Question: Condense the content of this figure into a single sentence.
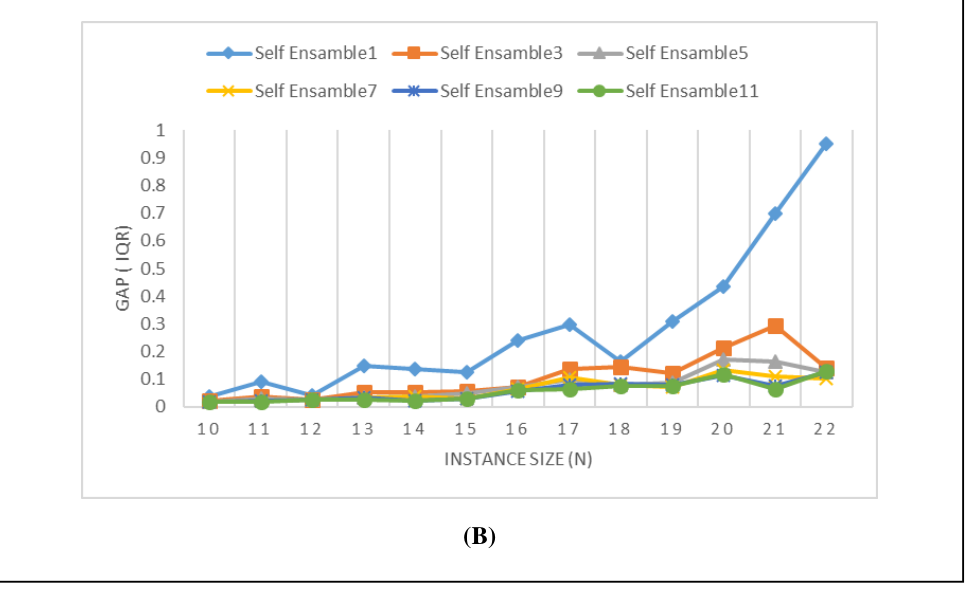
Answer: Median and interquartile for the gap of each group of journeys with similar size and different self-ensemble